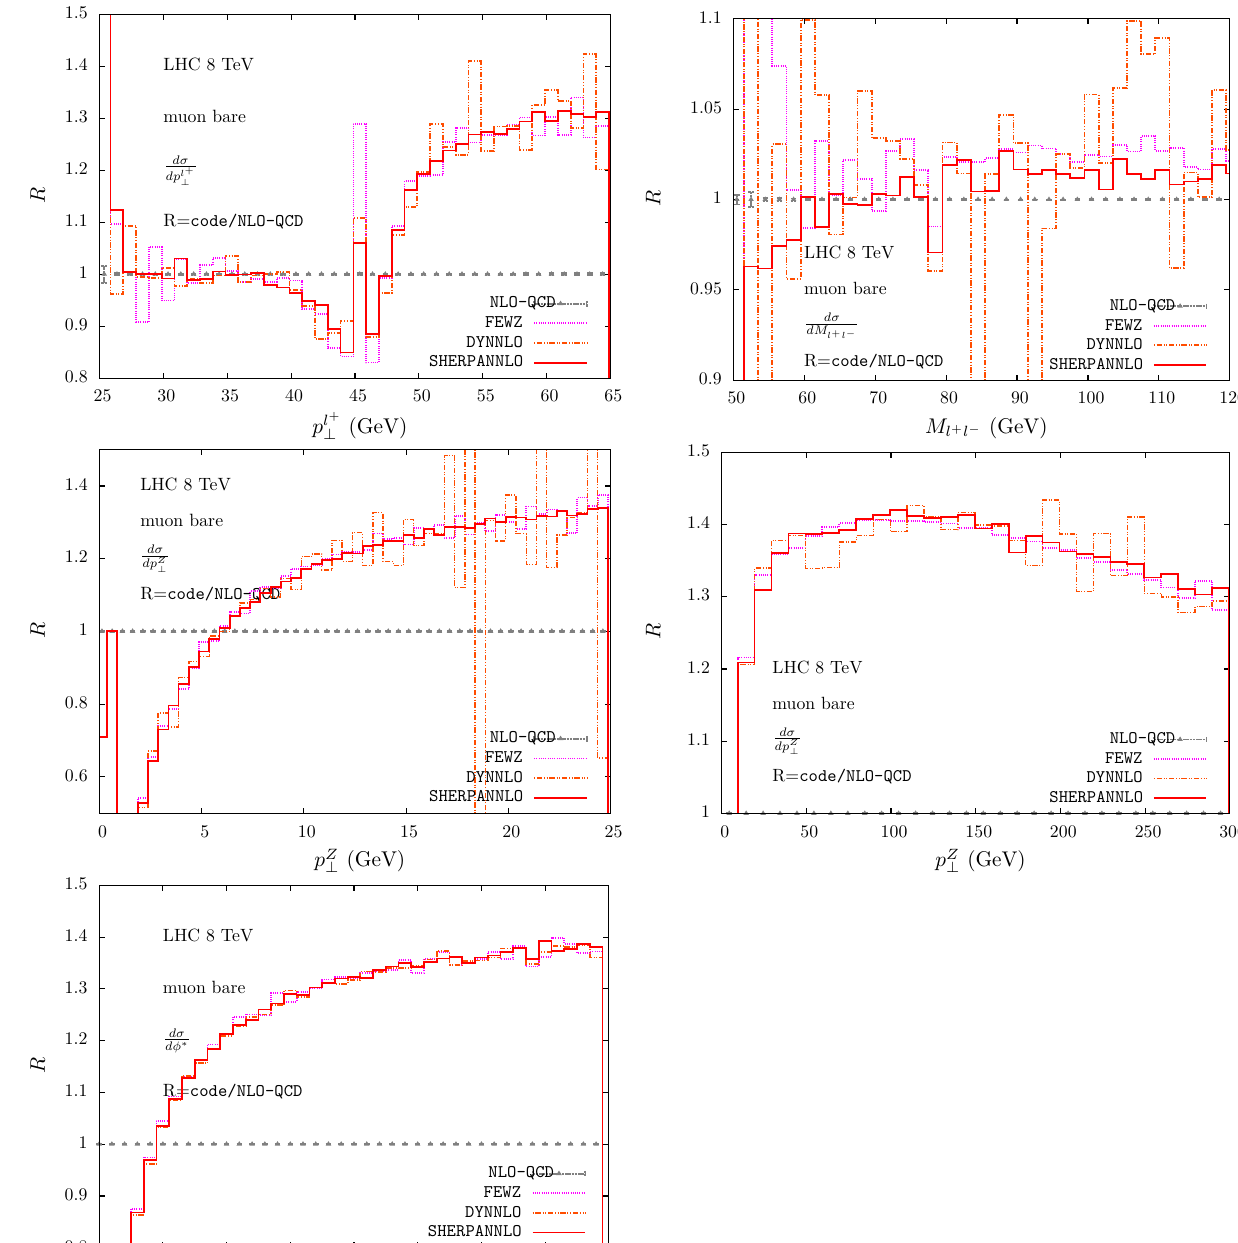
Fig. 19 NNLO QCD effects, expressed in units of NLO QCD, in pp → μ + μ − + X , in the benchmark setup with ATLAS/CMS cuts at the 8 TeV LHC. Comparison of the lepton transverse momen- tum ( upper left ), lepton-pair invariant mass ( upper right ), lepton-